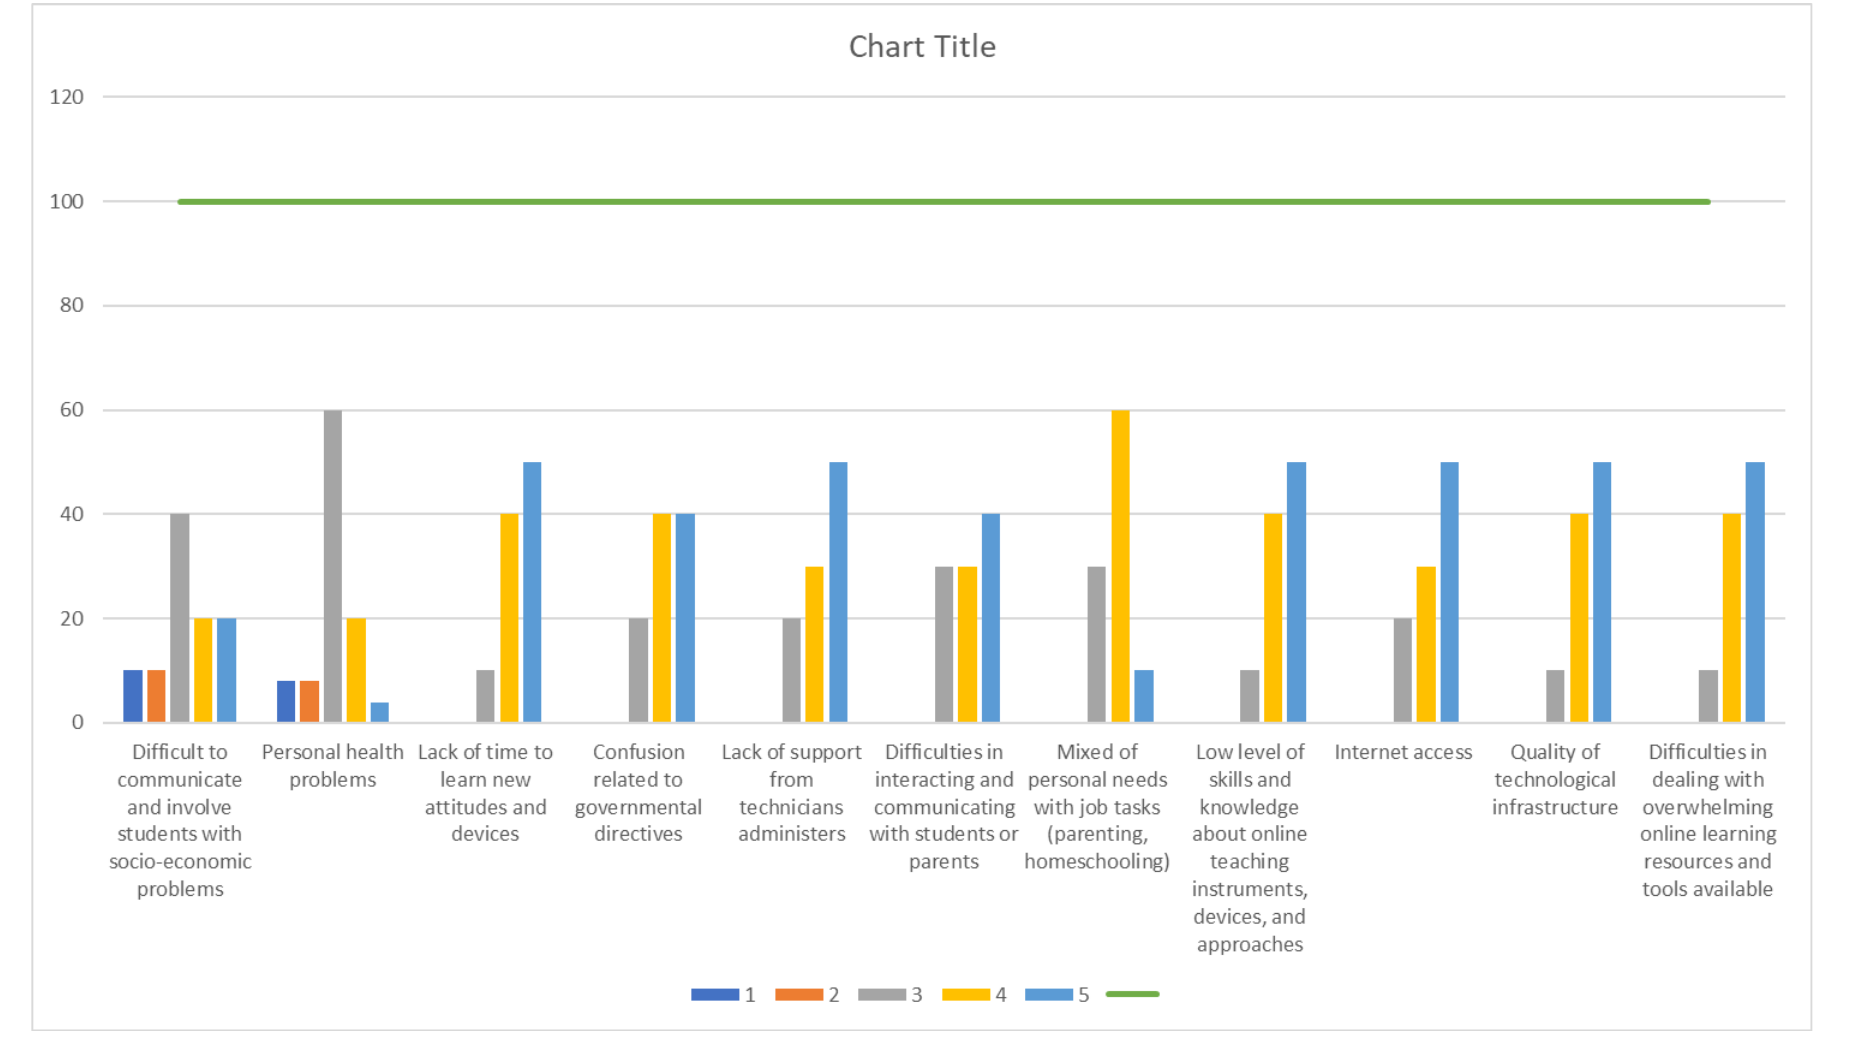
Figure 3. Online teaching challenges.